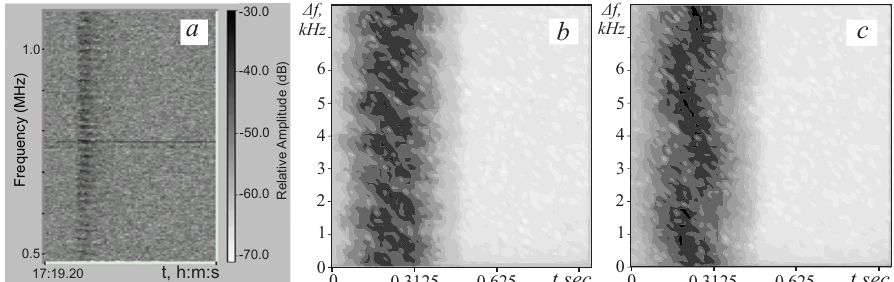
Fig. 2. The dynamic spectra of: (a) the elliptically polarized radiation from PSR B0809 +74, detected with UTR-2 ( F c = 23.7 MHz, ∆ F = 1.53 MHz); (b) the model signal ( F c = 20 MHz, ∆ F = 4 kHz); (c) the model signal ( F c = 30 MHz, ∆ F = 4